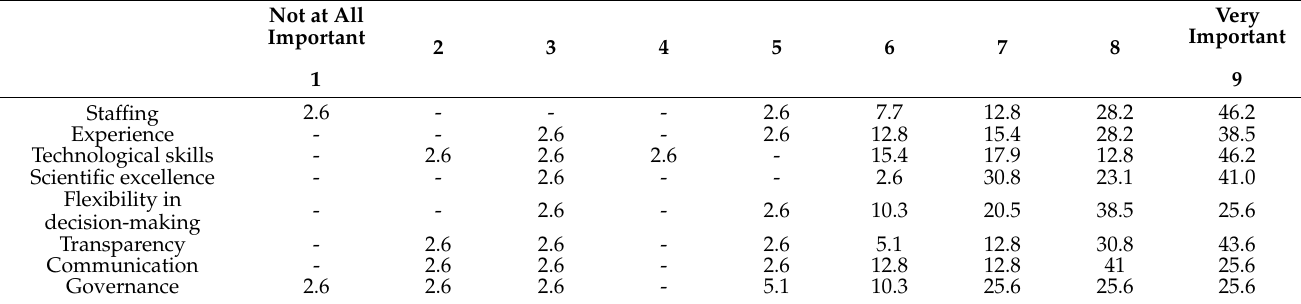
Table 13. Percentage units regarding the aspects of the operation and structure of the Hub ( N = 39). Not at All